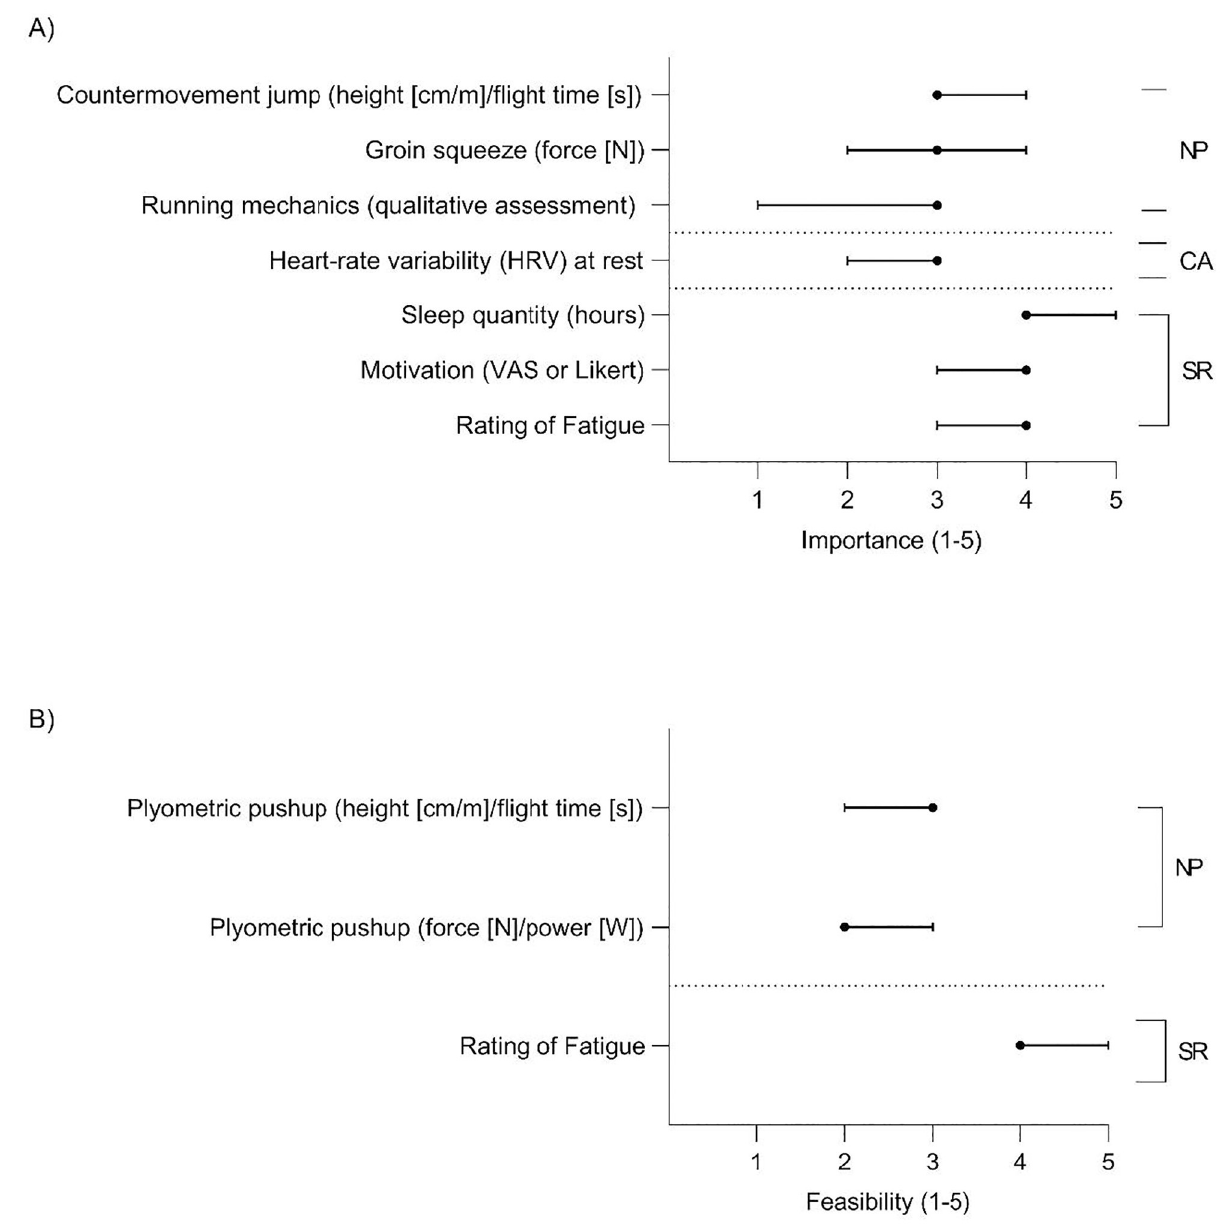
Fig 5. The SME ratings (median and interquartile range [IQR]) of A) importance, and B) feasibility to implement of the items which achieved consensus in round two of the Delphi questionnaire for the neuromuscular performance (NP), cardio-autonomic (CA), and self-reported (SR) domain measures. For importance, the scale ranged from 1 –not at all important, to 5—extremely important. For feasibility to implement the scale ranged from 1 –extremely difficult to 5 –extremely easy. If end of the IQR error bar(s) is not visible it is due to this being located at the median. N— Newtons, VAS—Visual Analogue Scale,